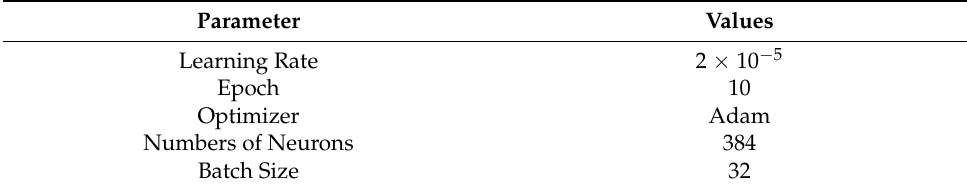
Table 1. Parameters